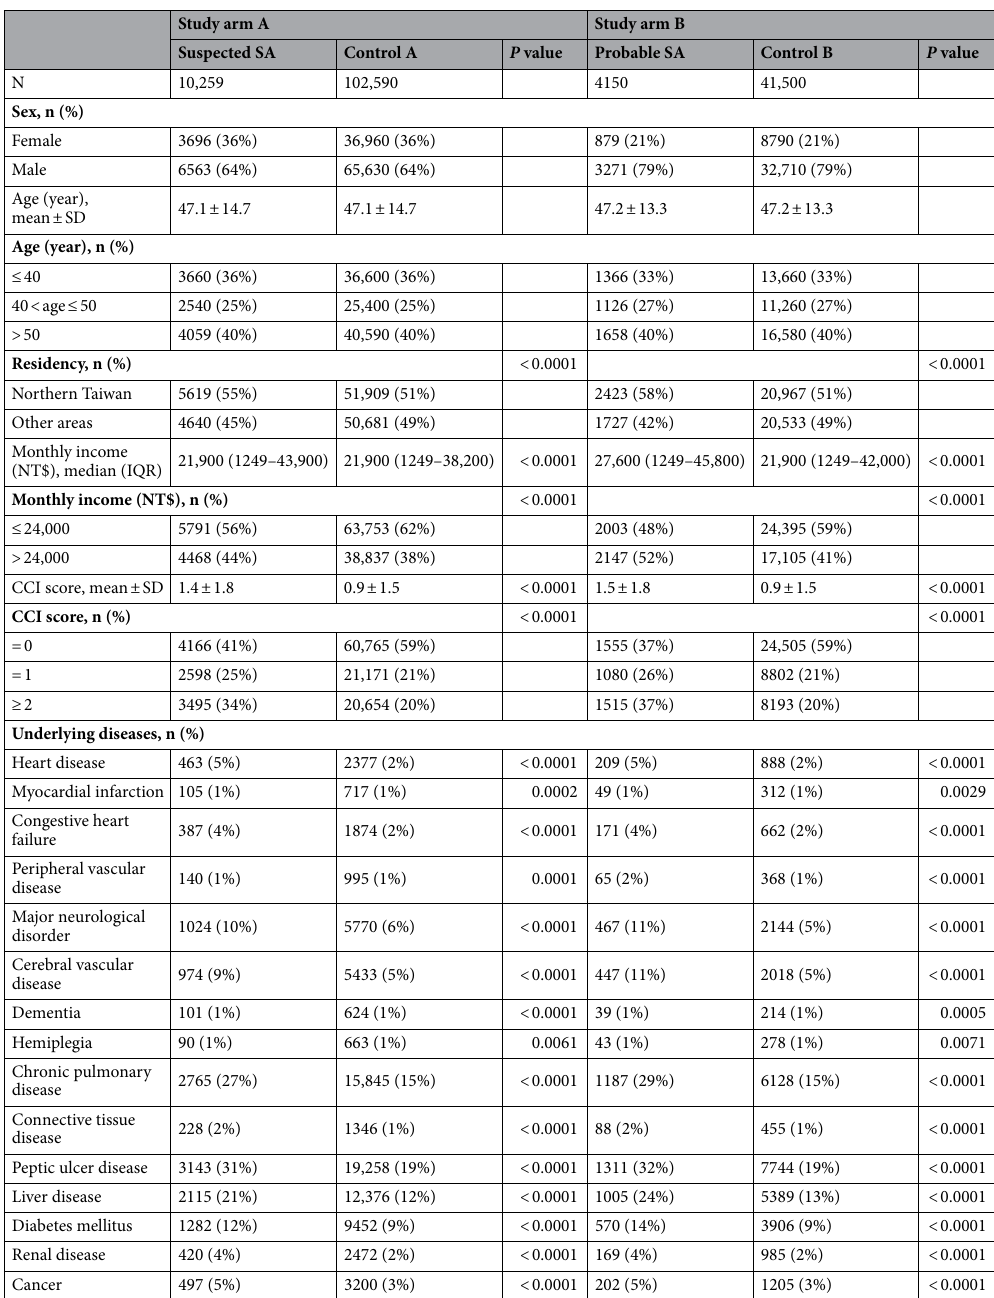
Table 1. Baseline characteristics of the study population. SA sleep apnea, NT$ New Taiwan Dollar, CCI Charlson Comorbidity Index, SD standard deviation, IQR interquartile